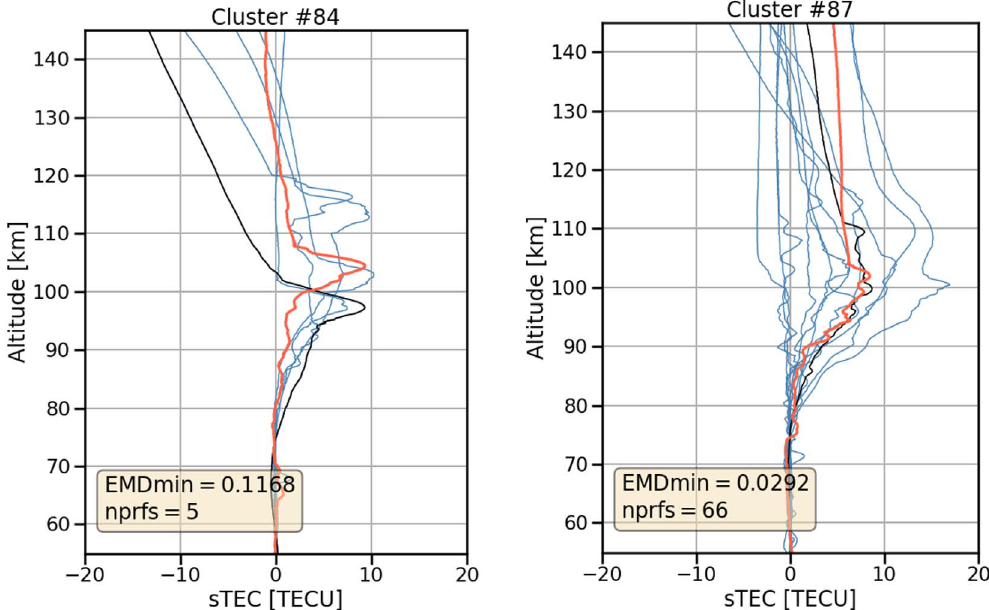
Fig. 12. Classi fi cation of a new sTEC pro fi le (in red) as Es (left panel) and TID (right panel). The black pro fi les represent the closest pro fi le with minimum EMD distance. Ten pro fi les from the same cluster are displayed in blue. The minimum EMD value and the total number of pro fi les in that cluster are displayed in the yellow box.